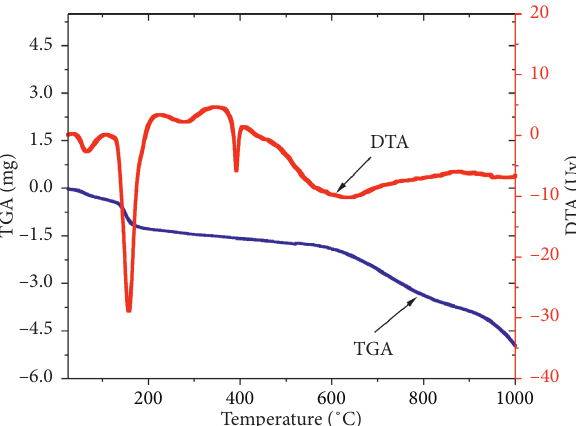
Figure 1: Thermal analysis of as-synthesized CuO NPs using Copper (II) nitrate trihydrate and Catha edulis synthesized using 1:10 ratio (w/v).